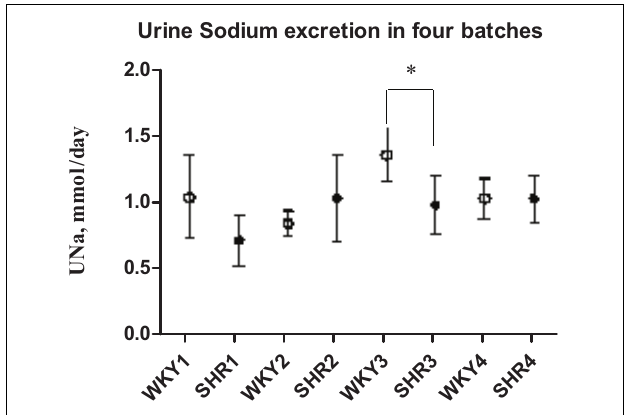
FIGURE 2 | Daily sodium urine excretion in four different batches of prehypertensive 3–4-week-old female SHR and age-matched WKY. Data are expressed as means ± S.D. ∗ p < 0.05 between SHR and WKY (batch 3). No difference in daily UNa excretion between the two strains in the other